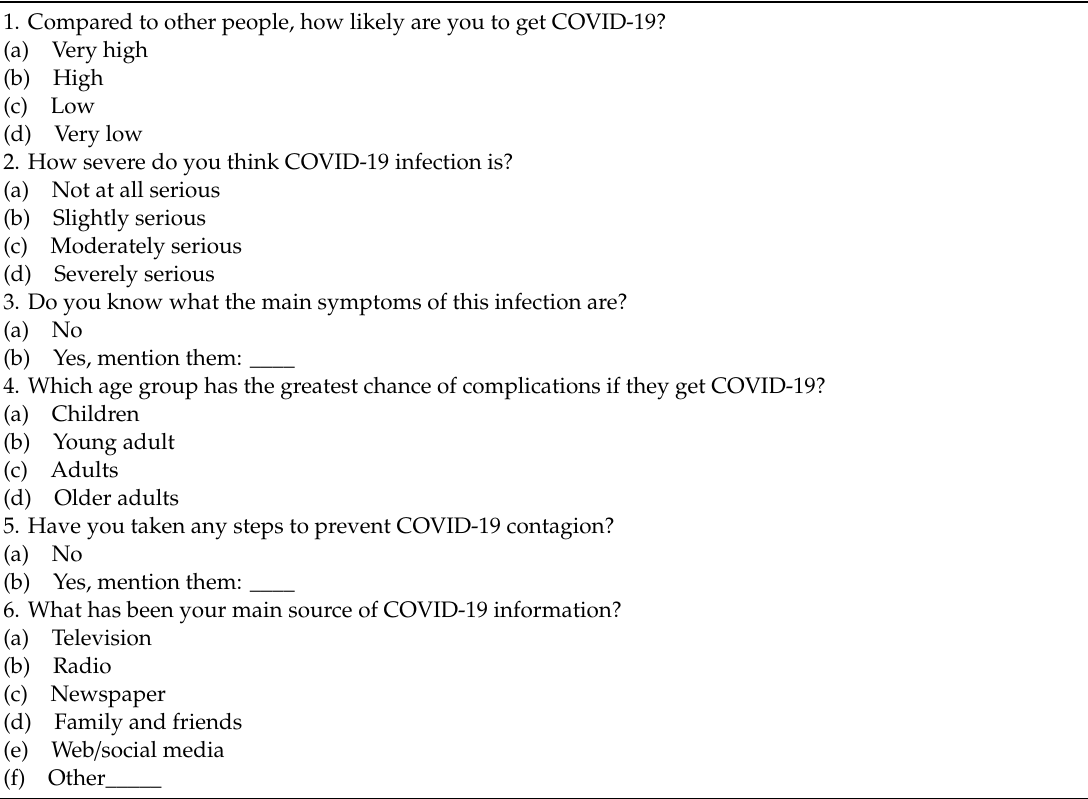
Table 1. Telephone interview questionnaire for adults aged 65 years and older, on the coronavirus (COVID-19) pandemic in Mexico